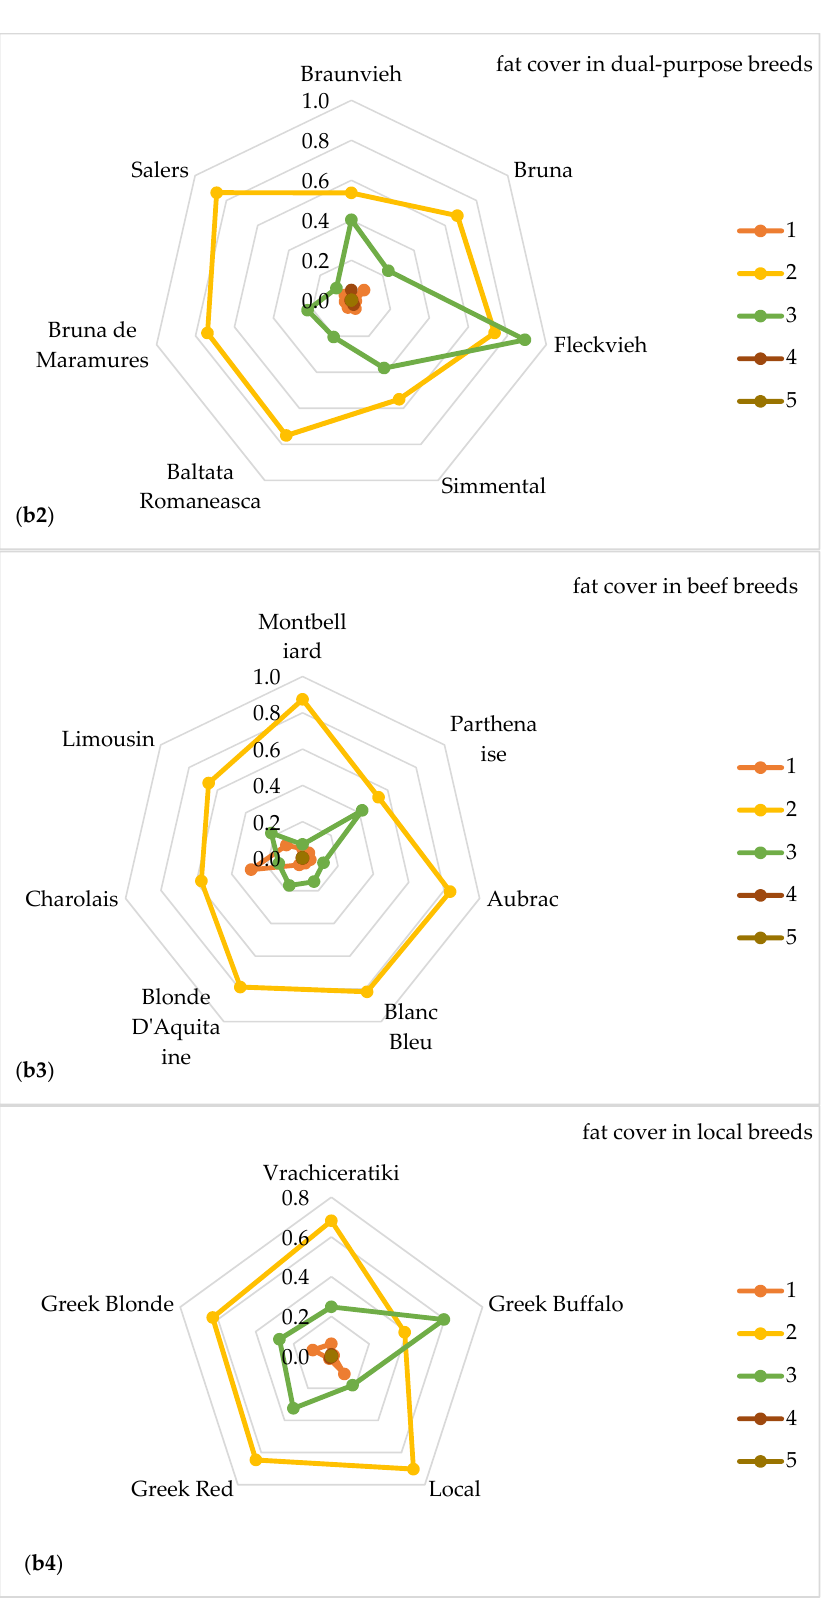
Figure 1. Proportions of muscle conformation ( a1 – a4 ) and fat cover ( b1 – b4 ) scores in grouped breed types of dairy ( a1 , b1 ), dual-purpose ( a2 , b2 ), beef ( a3 , b3 ) and local ( a4 , b4 ) cattle breeds according to SEUROP classification